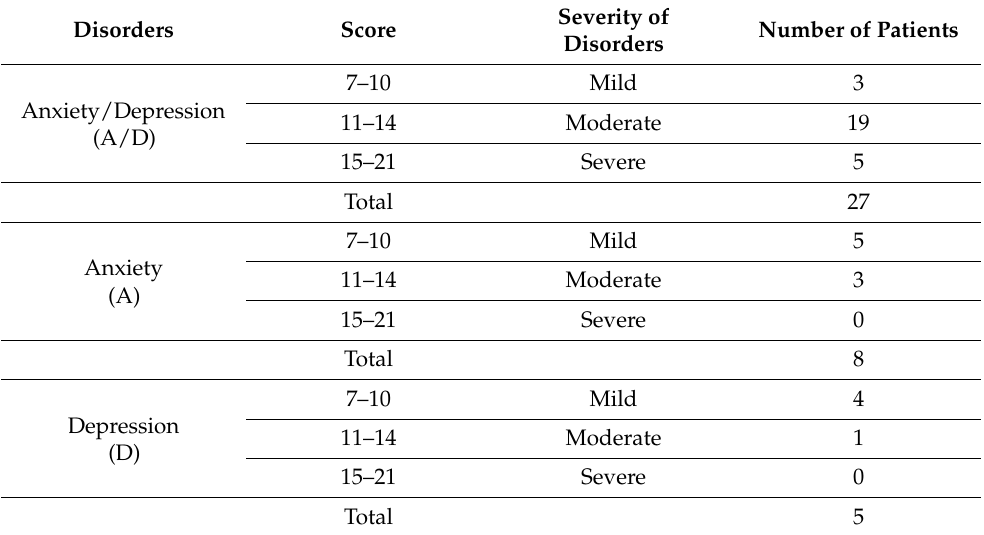
Table 3. Assessment of the degree of disorders according to the HADS scale in patients before the introduction of physiotherapeutic